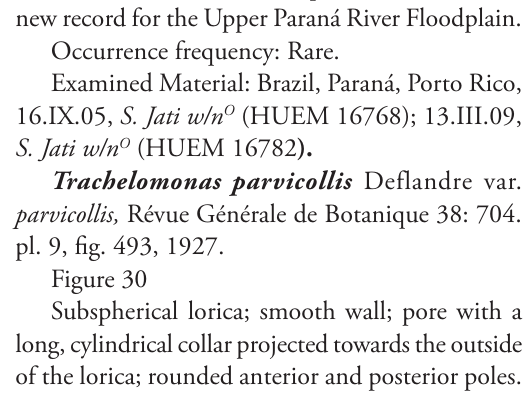
Subspherical lorica; smooth wall; pore with a long, cylindrical collar projected towards the outside of the lorica; rounded anterior and posterior